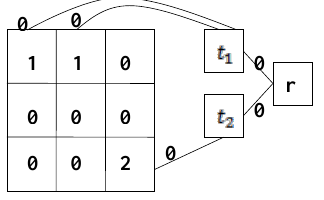
Figure 1. An example of addition of extra vertices t 1 , t 2 and r to the image graph for the construction of an MSF rooted on markers 1 and 2; non-marker pixels are denoted by “0.”